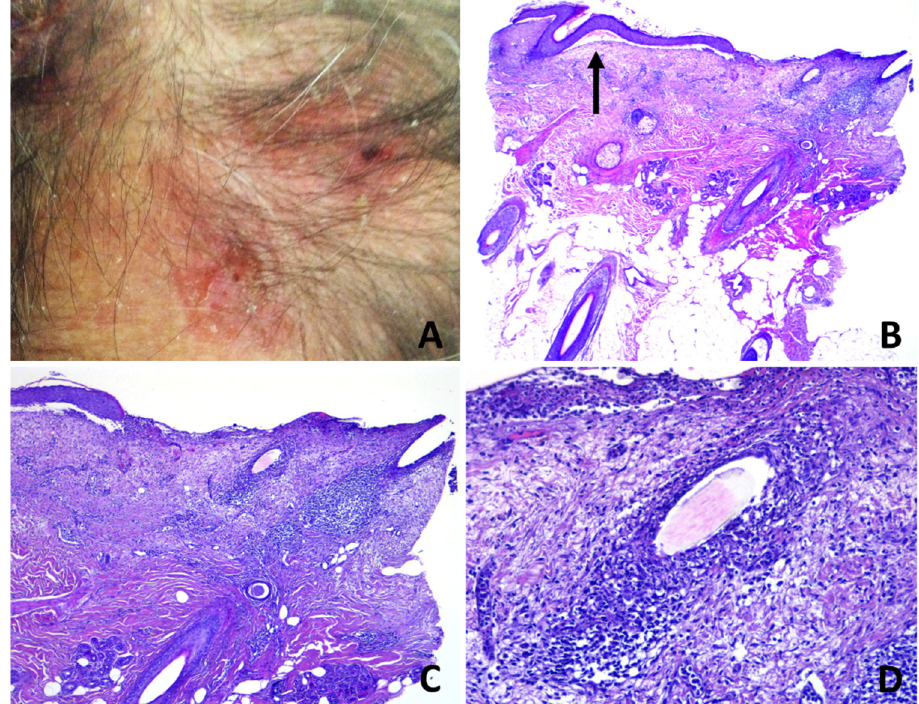
Figure 3. Erosive pustular dermatosis of the scalp; ( A ) erosions and crusts with a few follicular pustules; ( B ) partly eroded skin with underlying superficial folliculitis. A subepidermal clefting is evident (arrow); ( C ) perifollicular and interfollicular fibrosis; ( D ) total destruction of the upper portion of a follicular infundibulum by suppuration with retained hair shaft.